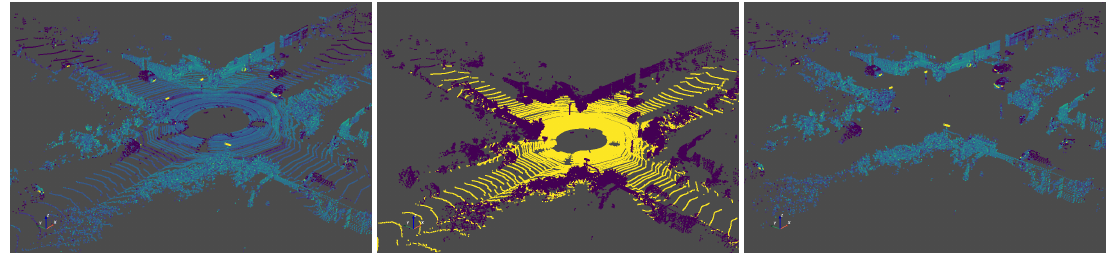
Figure 1. Common classification pipeline: first ground is detected. Then, object classification is simplified.